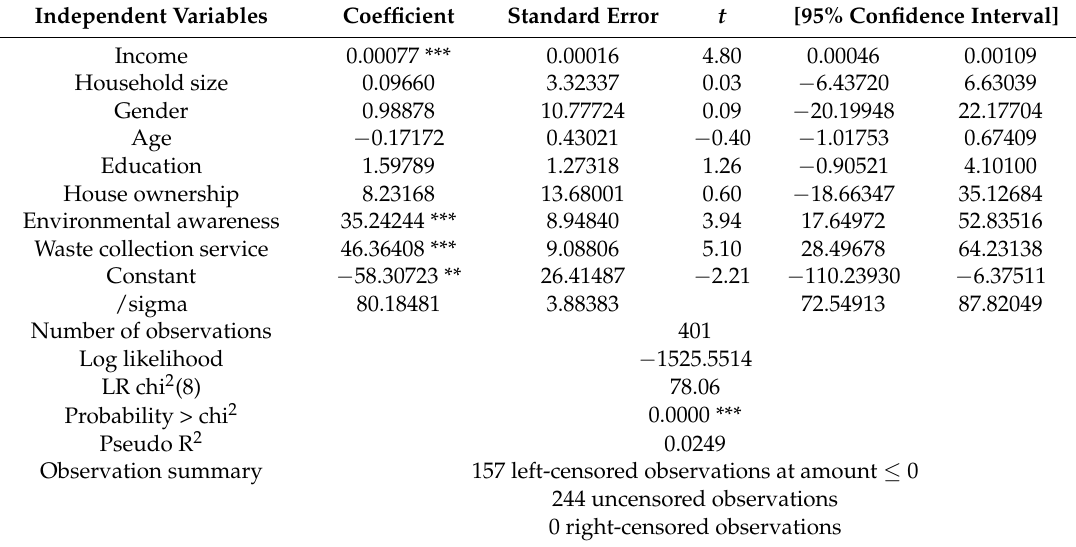
Table 7. Tobit regression results of factors influencing the amount of money households are willing to pay for improved waste collection